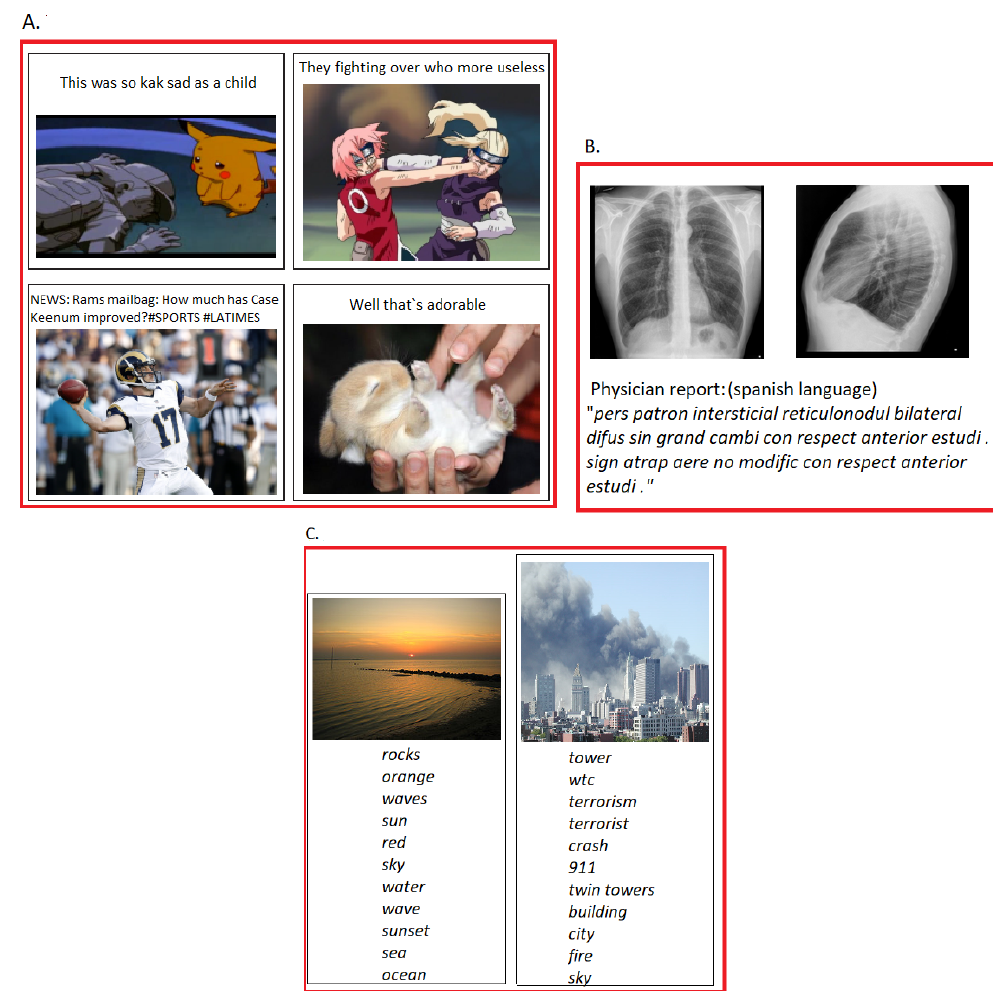
Figure 1. Motivation Figure: Our model treats language as a rich label space and generates subjective descriptions of images. Examples of samples used in the experimental evaluation. Each sample consists of a pair made of an image and the subjective text associated with it. ( A ) Samples of Text for Sentiment Analysis (T4SA) data set. ( B ) Samples of PadChest data set used in the experimental evaluation. The text is written in Spanish language. ( C ) Samples of ESP Game data set used in the experimental